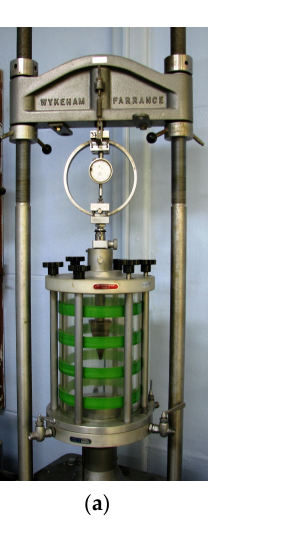
Figure 13. Basic equipment parts for underwater coal mining cutting resistance testing.